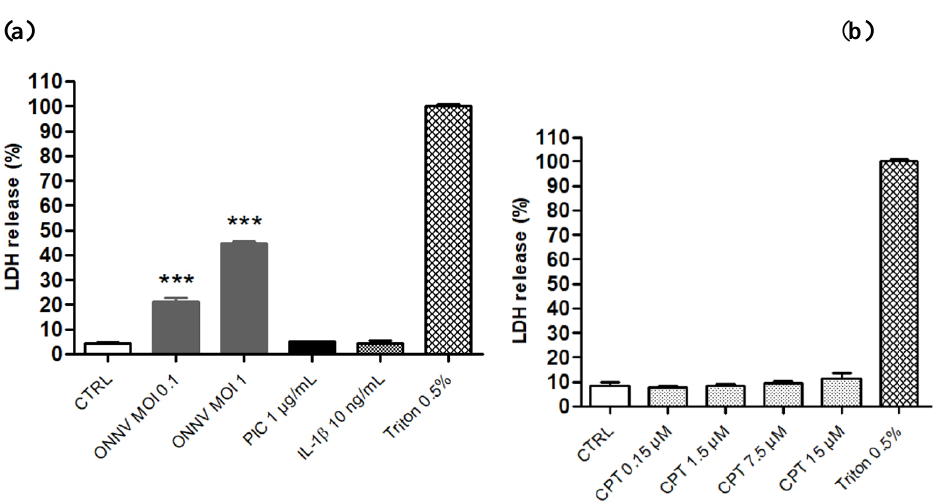
Figure 1. ONNV is cytotoxic for HSF. LDH activity was measured in culture supernatant 24 h after cell treatment with ( a ) ONNV at MOI 0.1 and 1, PIC at 1 µg/mL, IL- 1β at 10 ng/mL, and ( b ) CPT-11 at 0.15 to 15 µM. The percentage of cytotoxicity was calculated from the maximum LDH release following Triton X-100 exposure. Results are expressed as mean ± SEM of four independent